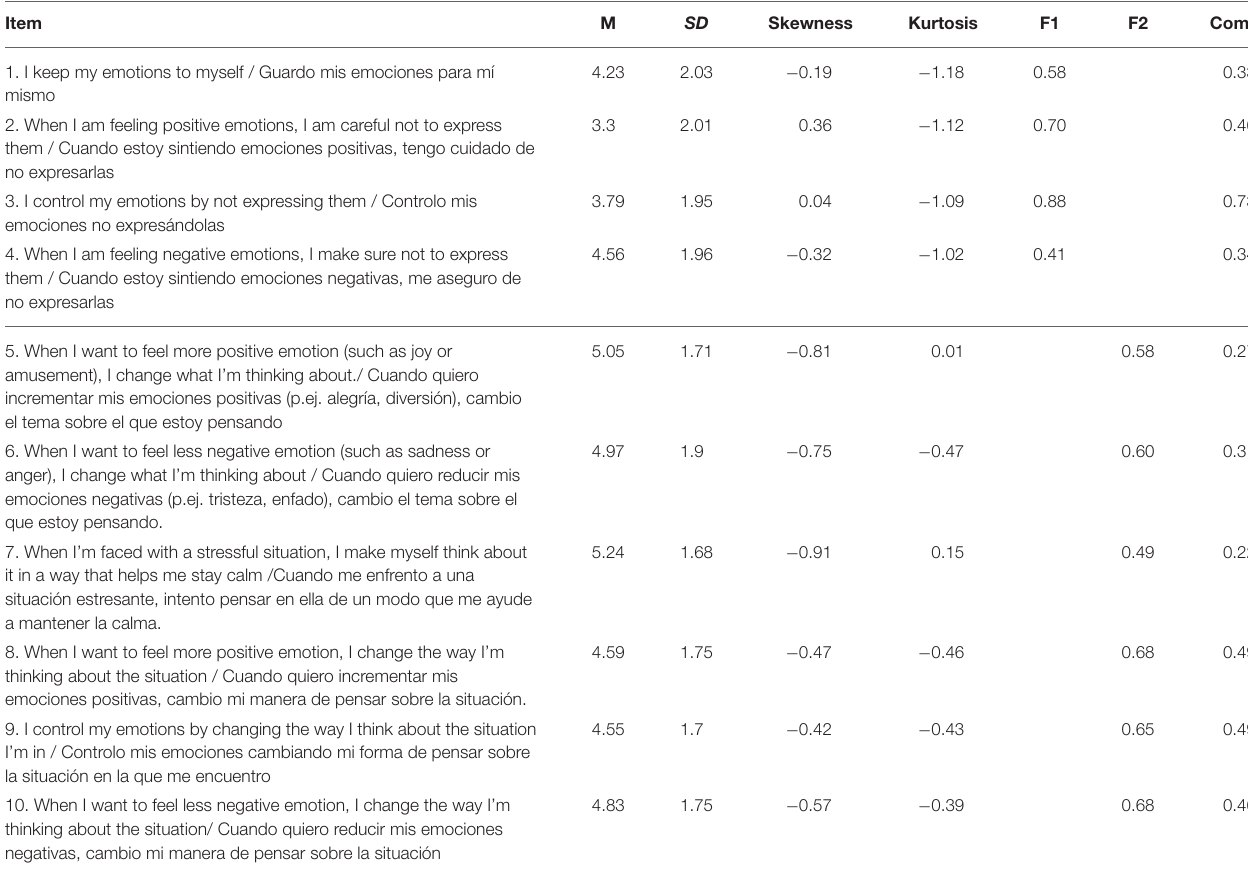
TABLE 1 | Descriptive univariate analysis and factor loadings and communalities of EFA. Item M SD Skewness Kurtosis